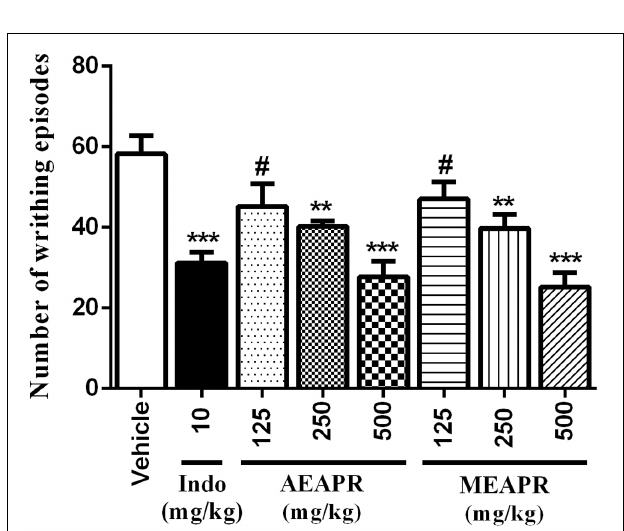
FIGURE 5 | Effect of orally administrated of MEAPR and AEAPR on acetic acid-induced writhing movements in mice. Animals were treated orally with vehicle (distilled water), indomethacin (Indo), MEAPR or AEAPR (125, 250, and 500 mg/kg), prior to acetic acid injection (0.6%, i.p.). Each point represents mean ± SEM of writhes number for six mice per group. The symbols denote the significance levels: ∗∗ p < 0.01 and ∗∗∗ p < 0.001 in comparison with the vehicle-treated group; # p < 0.05 in comparison with the indomethacin-treated group, using Newman–Keuls post hoc